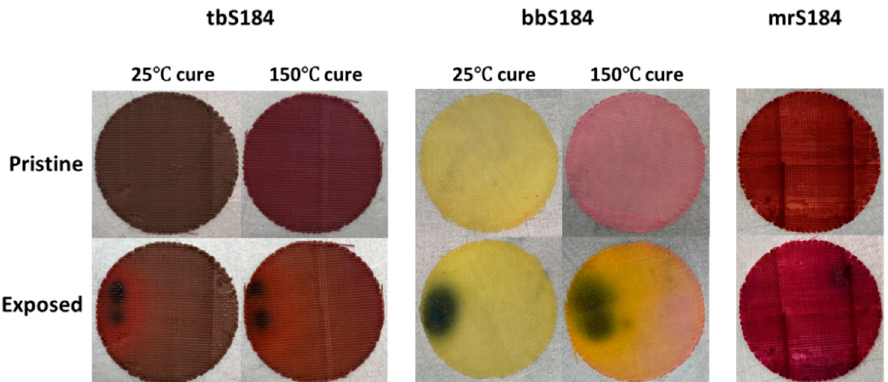
Figure 7. Comparison of the color changes in some of the 3D printed sensors—The sensors tb184 and bbS184 exhibited a color change when cured at an elevated temperature but it did not disrupt their sensing ability. Additionally, the porosity in the 3D printed sensors aided in providing a better visual cue for when tbS184 and mrS184 were exposed to basic or acidic chemical species, respec-